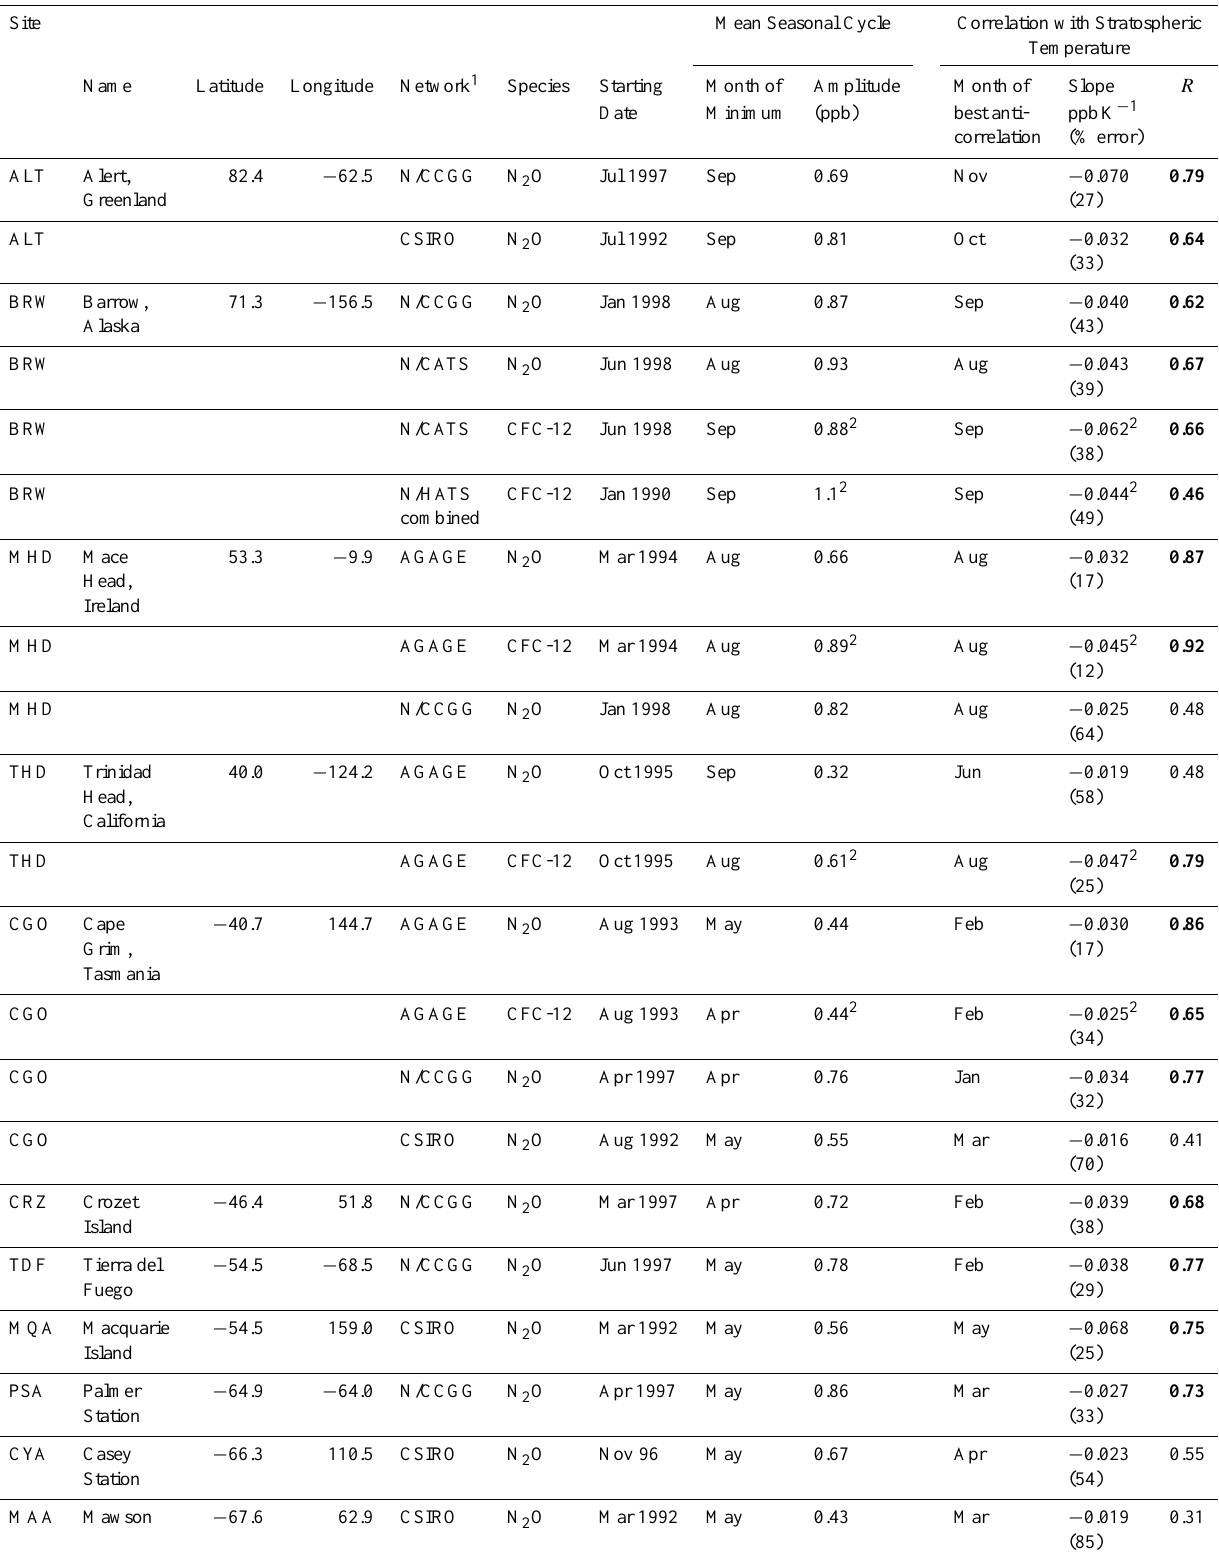
Table 1. Correlations between N 2 O seasonal minimum anomalies and mean polar (60 ◦ –90 ◦ ) lower stratospheric (at 100hPa) temperature for January–March (Northern Hemisphere) or September–November (Southern Hemisphere). Bold type in final column indicates statistically significant correlations ( p ≤